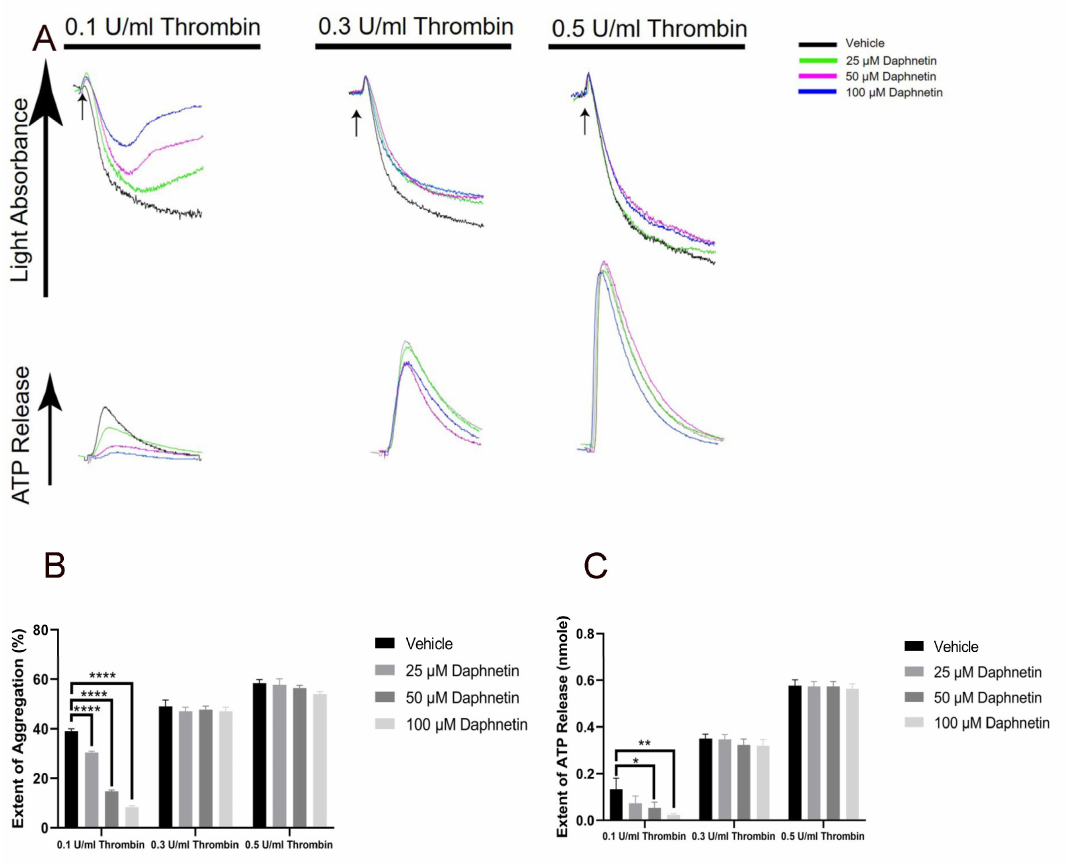
Figure 4. The effect of daphnetin on thrombin-induced platelet aggregation and secretion. ( A ) Washed murine platelets were stimulated with 0.1 U/mL, 0.3 U/mL, and 0.5 U/mL thrombin in the presence of different concentrations of daphnetin. Quantification of the ( B ) extent of aggregation and ( C ) dense granule secretion from panel A. Data are representative of three independent experiments ( n = 3) and are presented as mean ± SE *, p < 0.05; **, p < 0.01; ****, p < 0.0001.